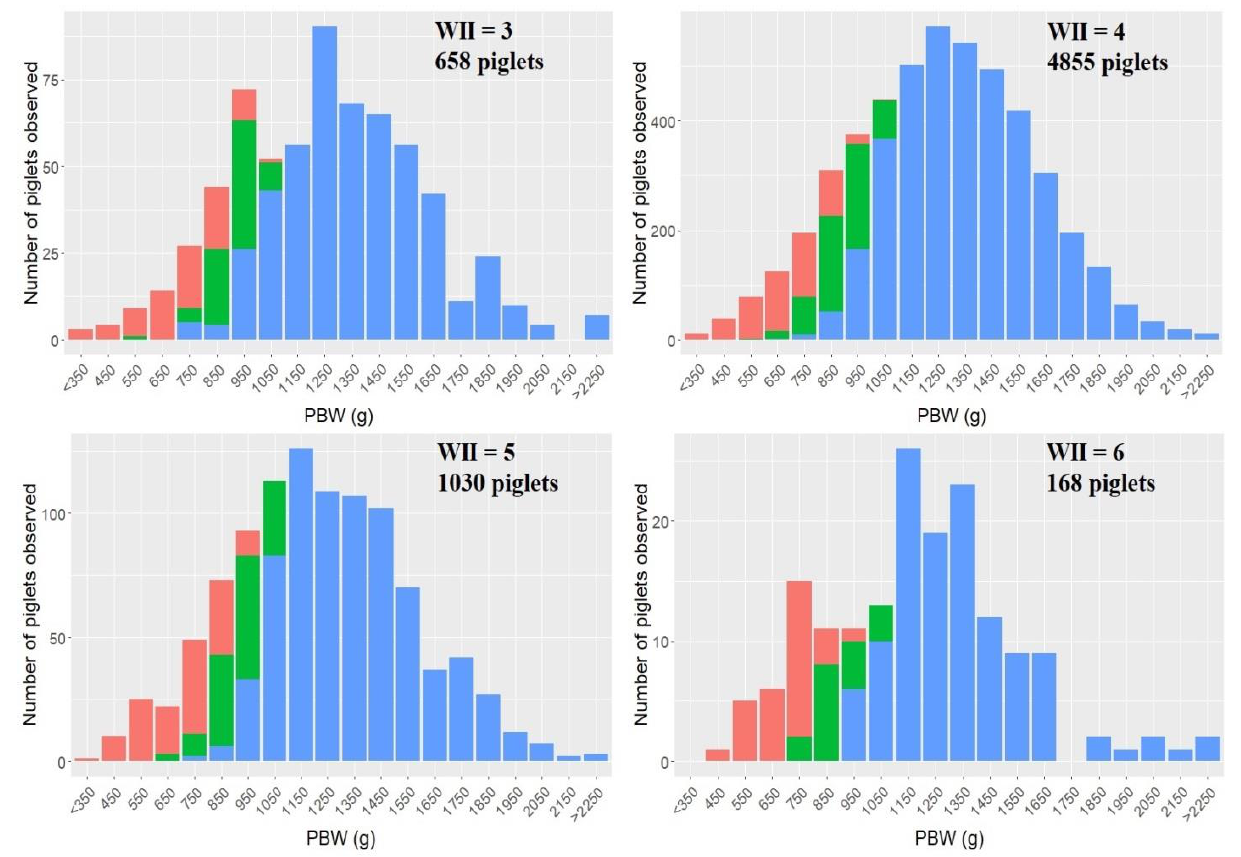
Figure 4. Distribution of piglets by piglet birth weight (PBW) classes of different weaning to insemination intervals (WII) with the number of piglets observed of each WII and classification of piglets as either normal (blue), mild IUGR (mIUGR (green)) or severe IUGR (sIUGR (red)). Values on the x -axis cover ± 50 g. It should be noted that the majority of piglets were born of sows with a WII of four days, and the y -axis are differently